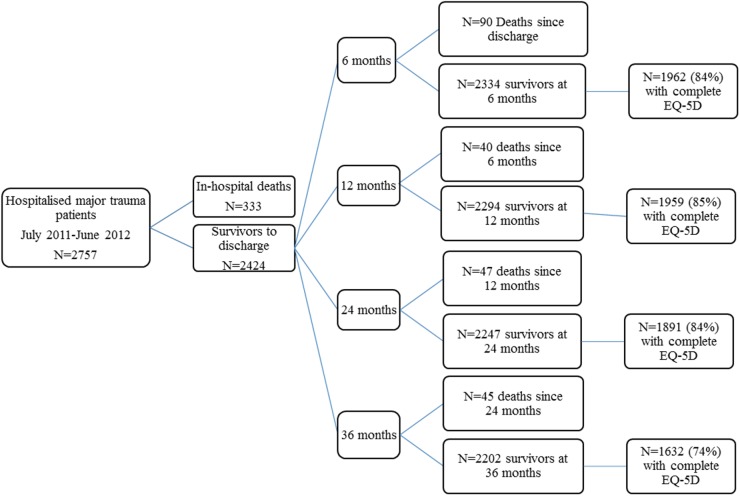
Flow of participants through the study.